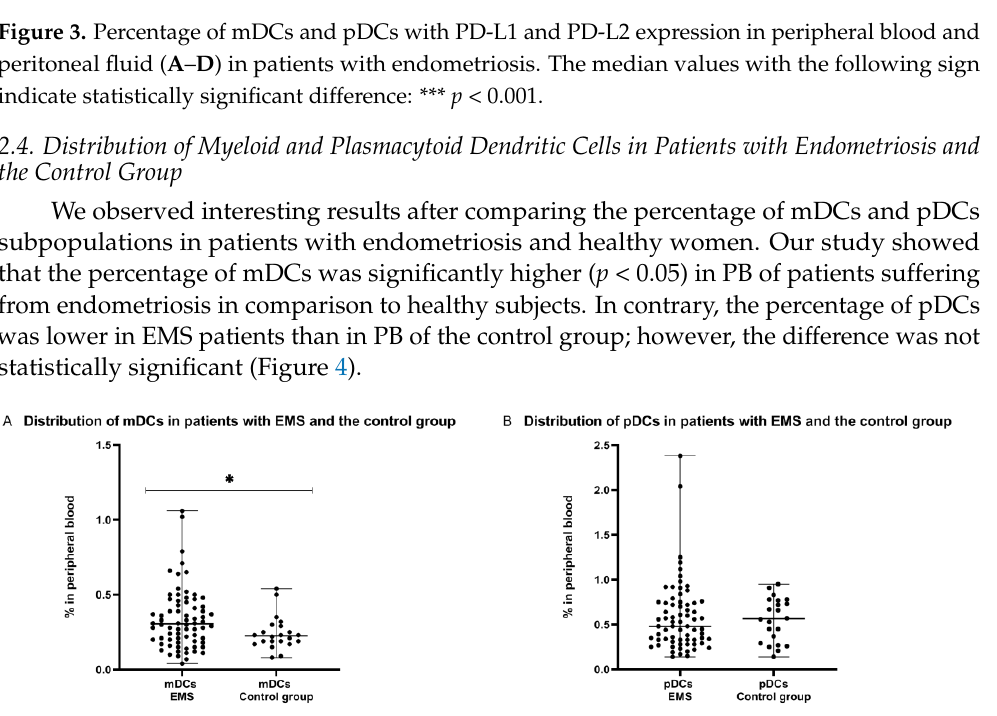
Figure 4. Percentage of mDCs ( A ) and pDCs cells ( B ) in peripheral blood in patients with endometrio- sis and control group. The median values with the following sign indicate statistically significant differences: * p < 0.05.